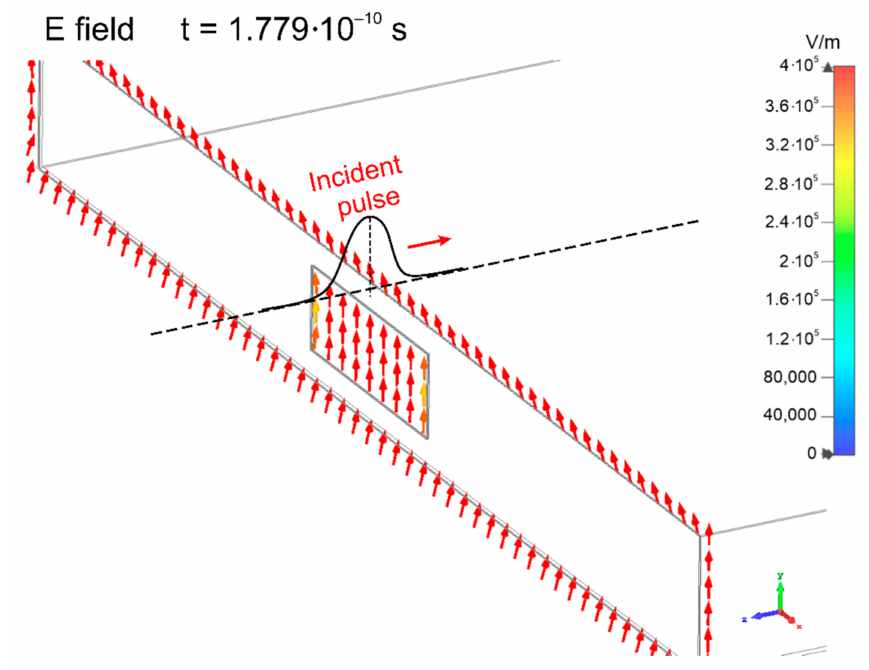
Figure 6. The electric field strength in the aperture of the shielding enclosure (z = 231 mm, t = 0.1775 ns). The electric field amplitude in the enclosure was equal to that of the incident pulse (10 6 V/m). The current position of the incident pulse is shown. Retrieved from Figure 3Eb.